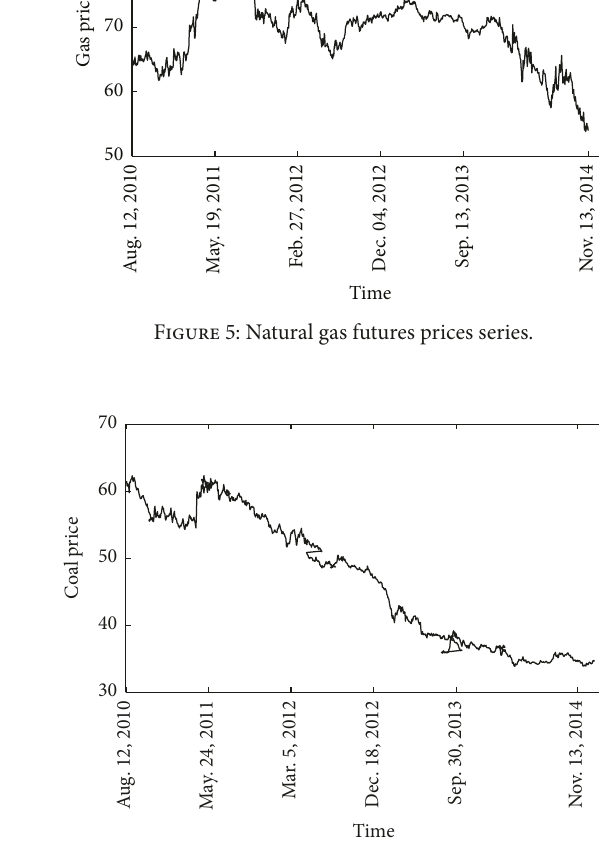
Figure 6: Coal price